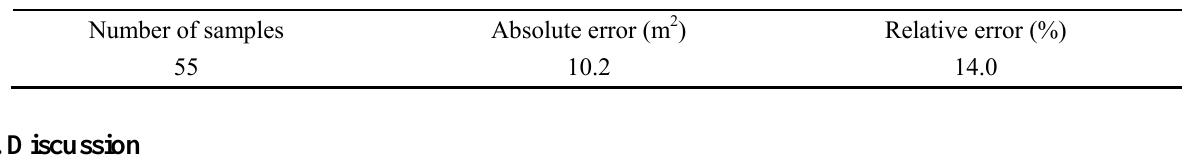
Table 5. Absolute and relative error of ground area of building